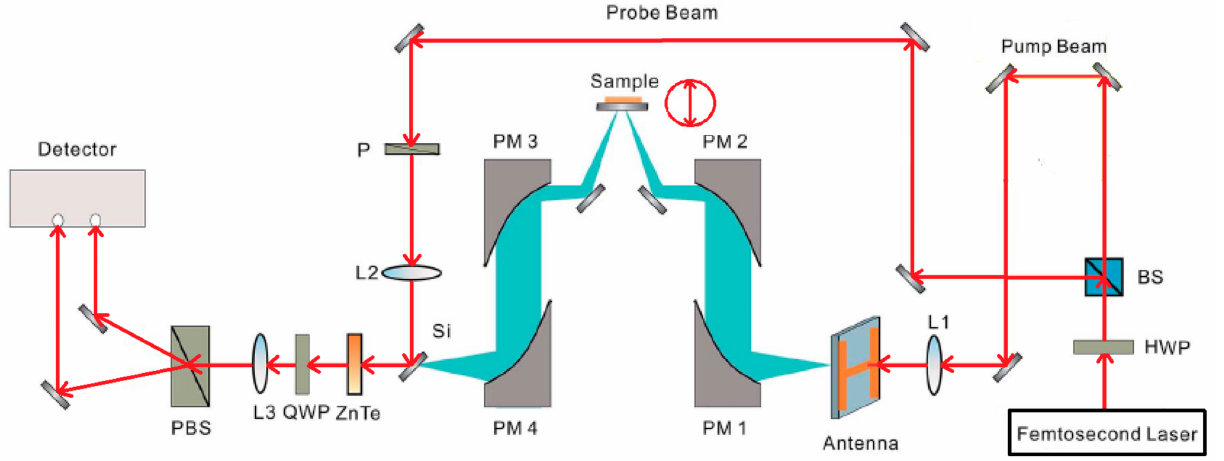
Figure 3. THz-TDS reflection imaging